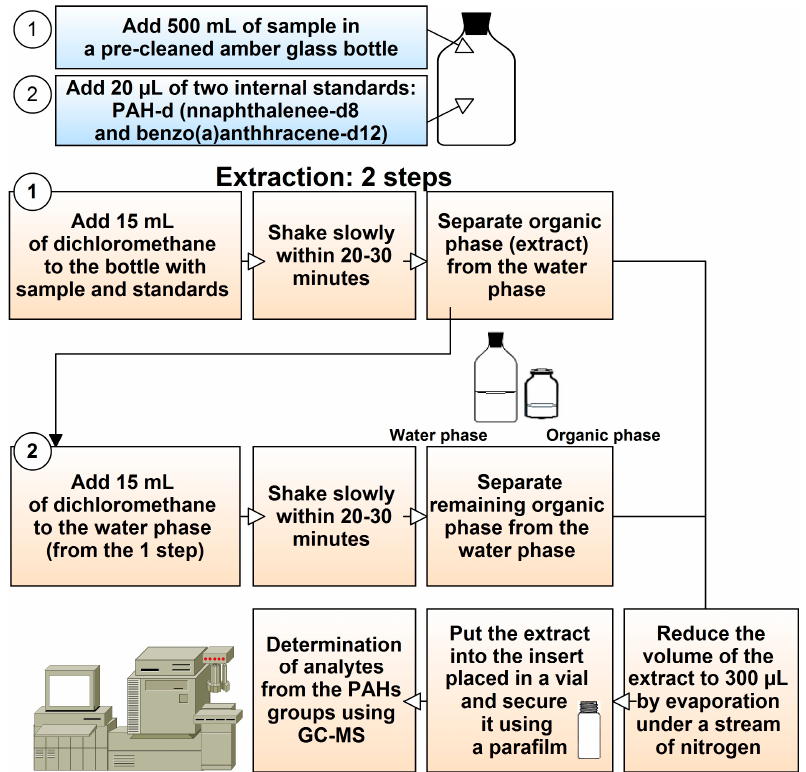
Figure 3. Scheme of extraction and preconcentration of surface water samples for determining PHA concentrations.